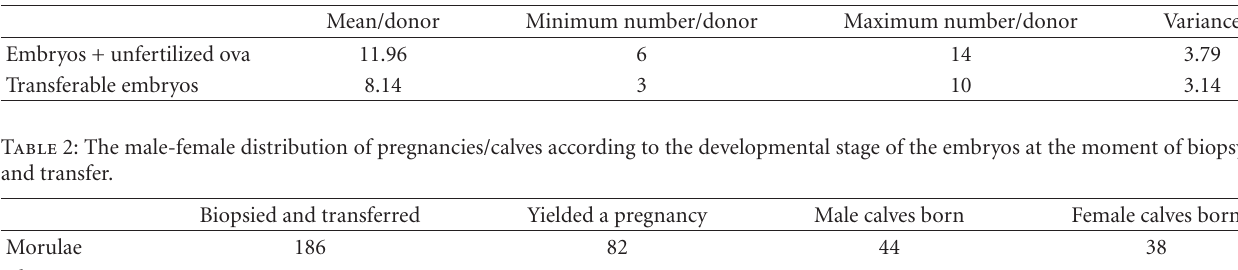
Table 1: The distribution of total and transferable embryos recovered from the 50 donor cows.